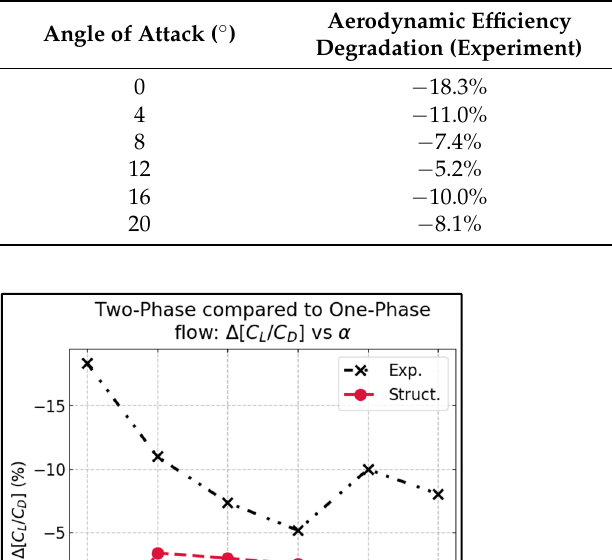
Table 3. L/D percentage degradation due to the existence of second phase (sand).